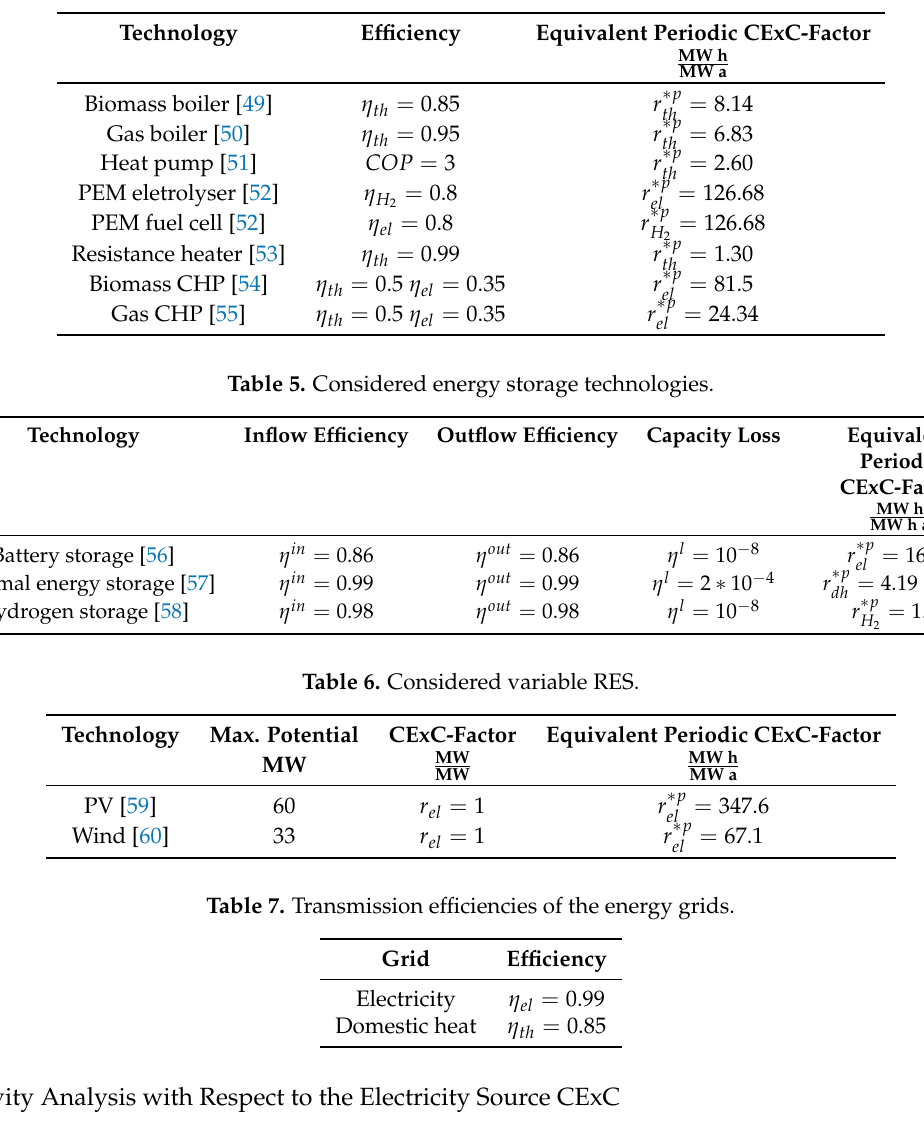
Table 4. Conversion units: considered conversion technologies.